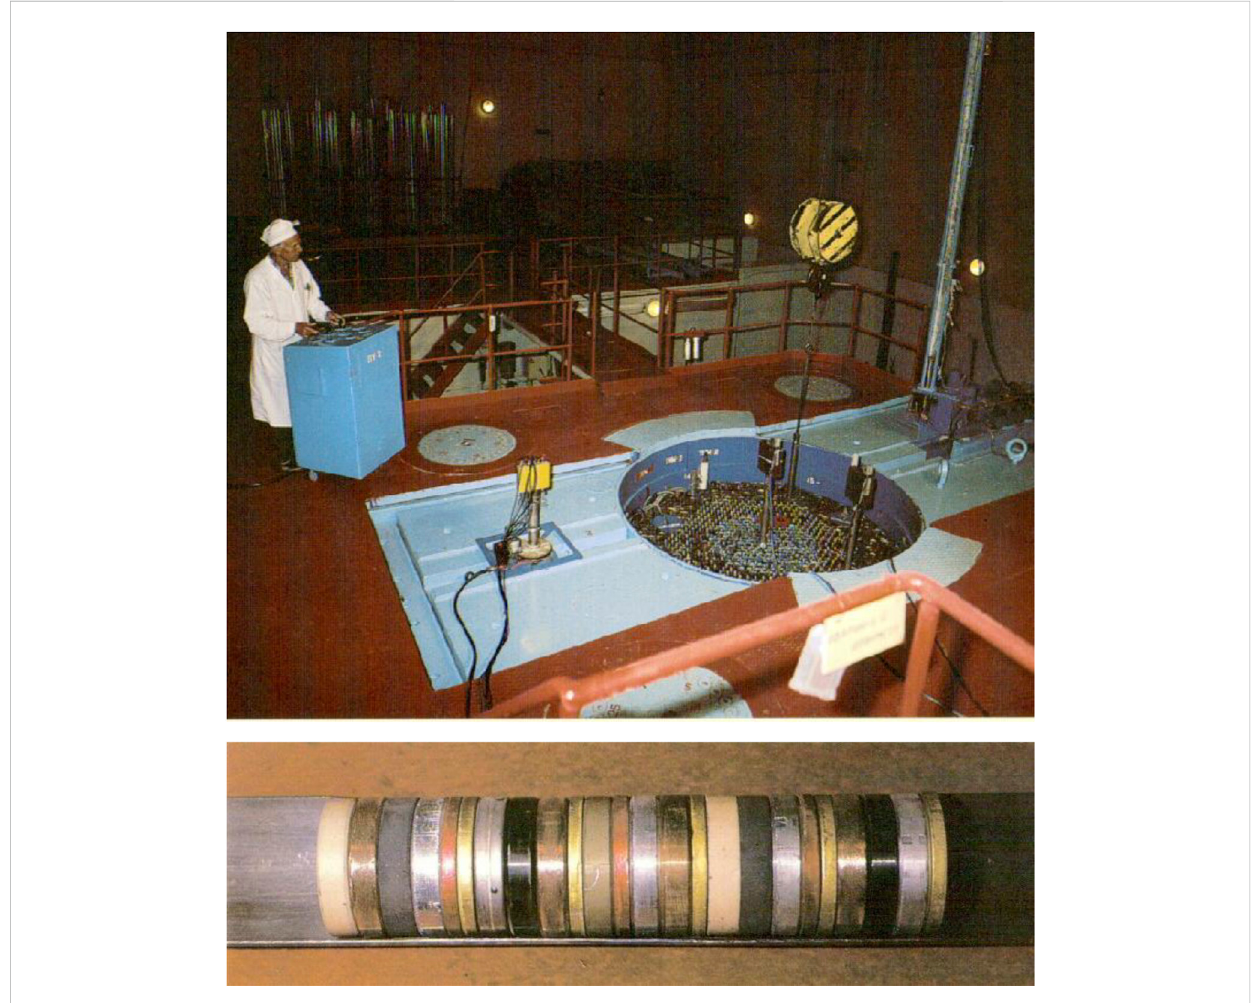
BFS-1 critical facility (Top) and example fuel pellet loading